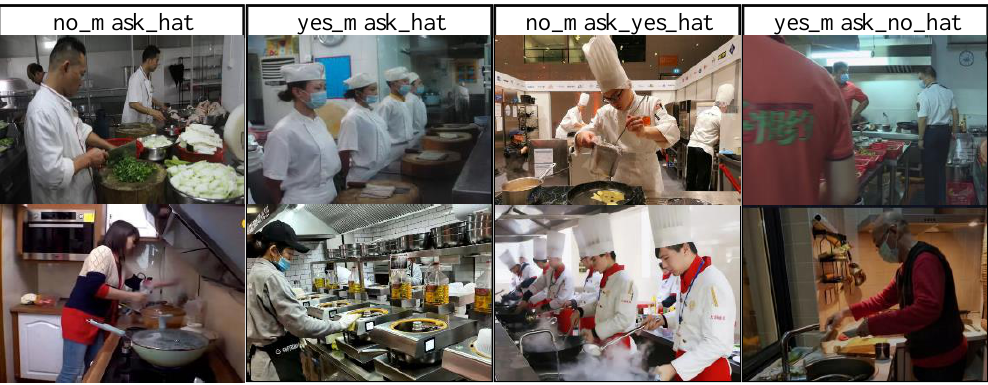
Figure 4. Kitchen standard dress detection images in complex environments.